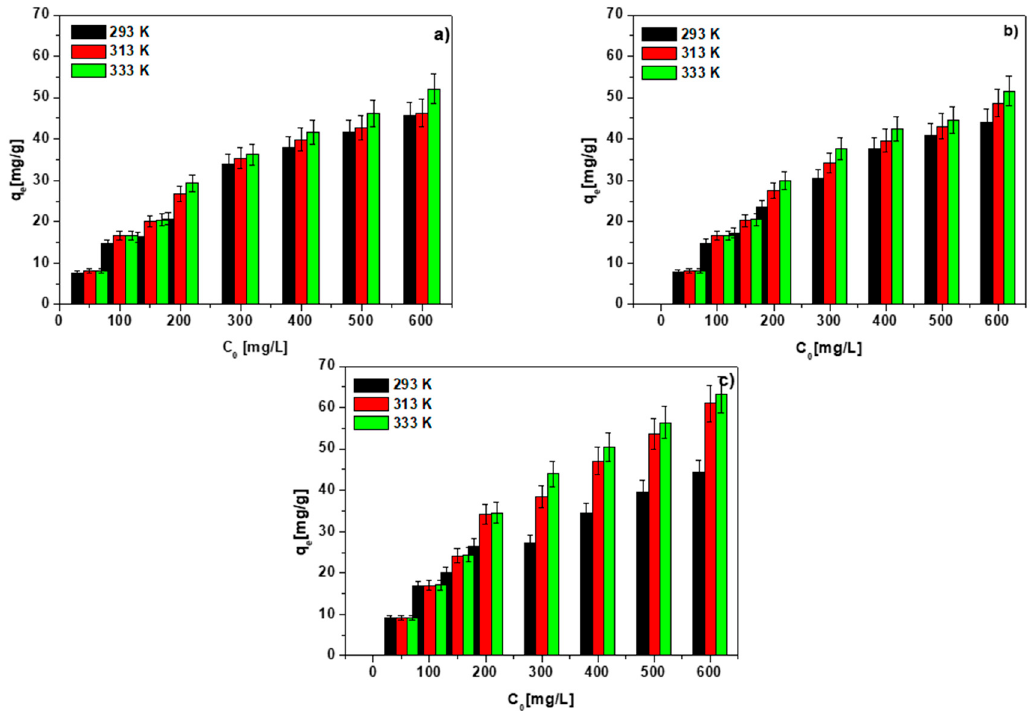
Figure 12. Effect of temperature on the Cu(II) sorption on ( a ) BC-CS 1-1, ( b ) BC-CS 2-1 and ( c ) BC-CS 4-1 (C 0 50–600 mg/L, sorbent mass 0.1 g, pH 5, shaking speed 180 rpm).